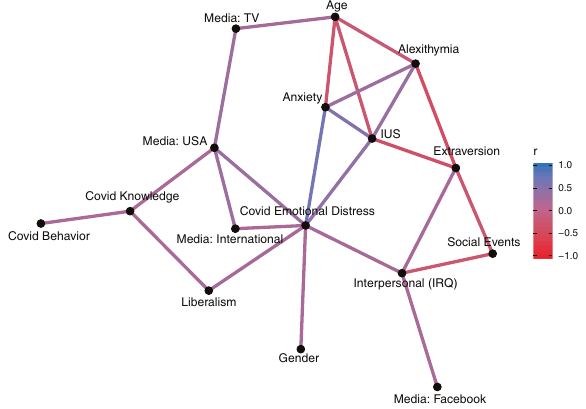
Fig. 2 Correlation network between variables in CV model. Partial correlations between all variables in the fi nal cross-validated model (only correlations exceeding an absolute value of 0.2) are plotted in a network. Nodes indicate variables while the color of edges re fl ects the correlation between variables. All variables with “ Media ” refer to media consumption about COVID-19.